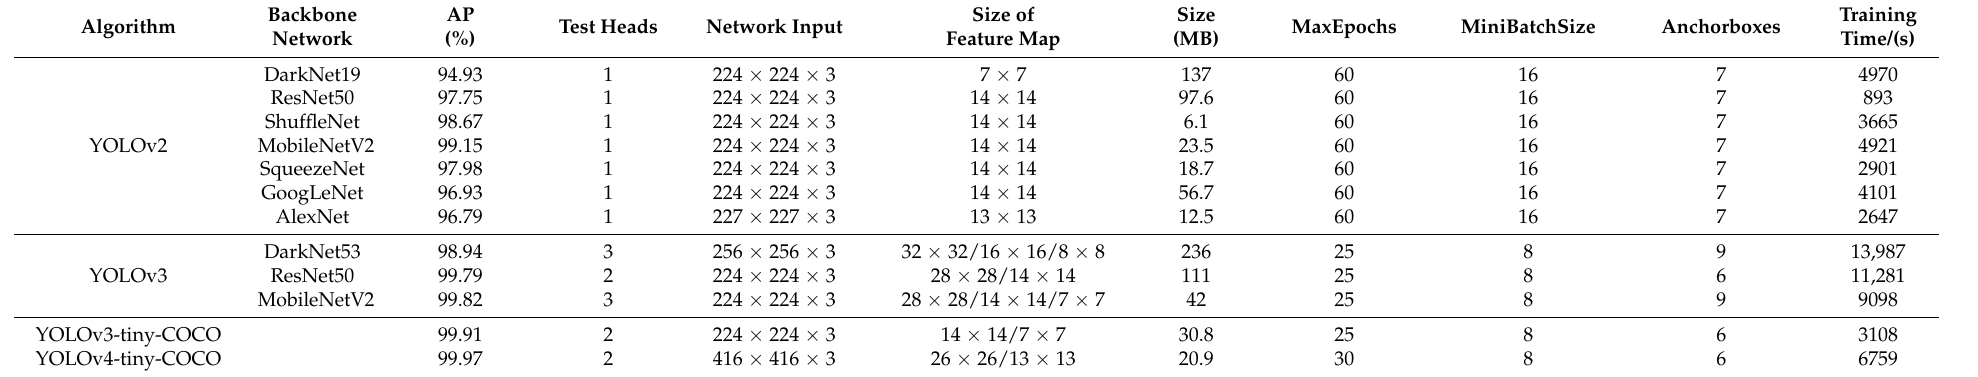
Table 2. Comparison of model